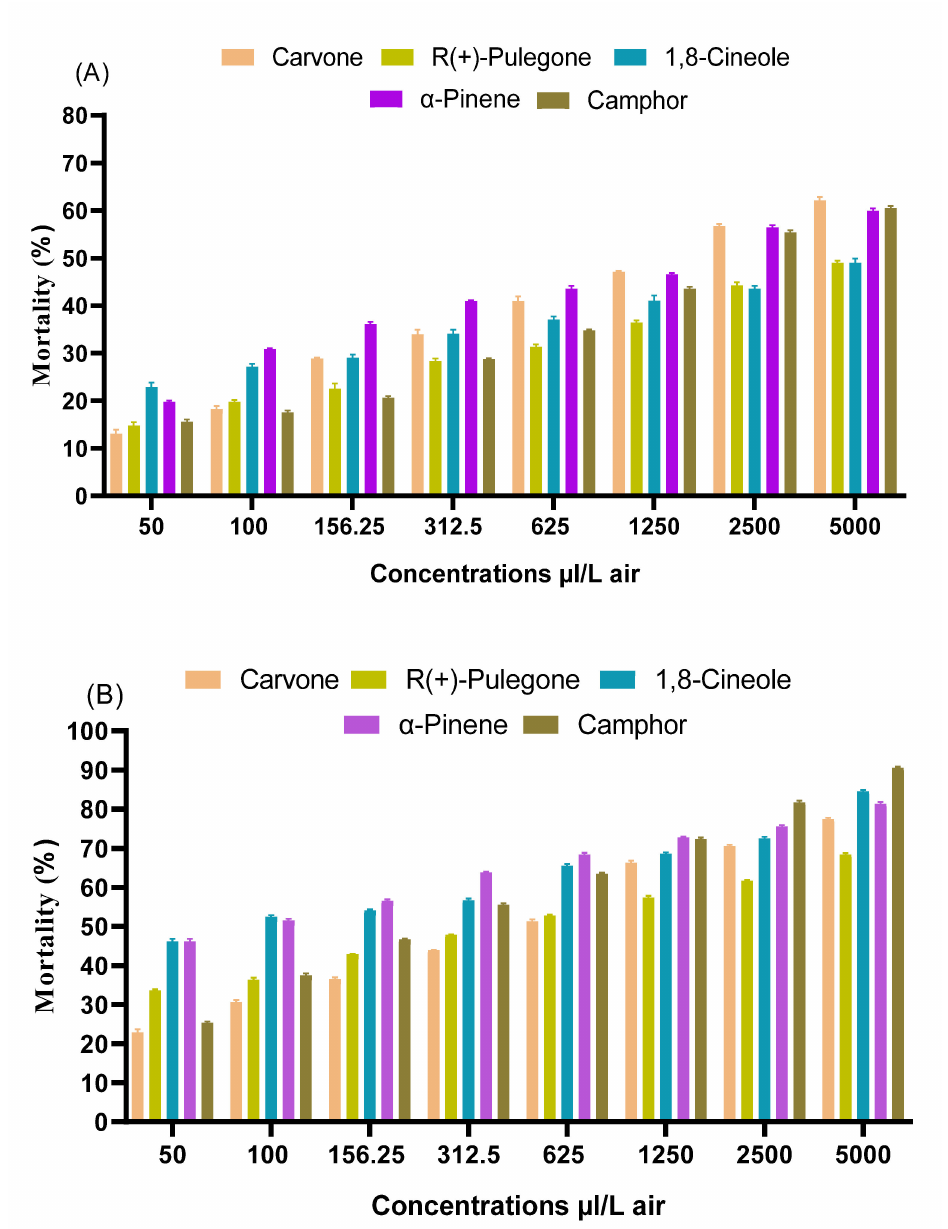
Figure 2. Toxicity of monoterpenes against C. pipiens adults at various concentrations after 24 h ( A ), and 48 h ( B ) of treatment. Results are means of three replicates ( n = 3). Bars indicate standard errors. Tests were statistically significant at p -value